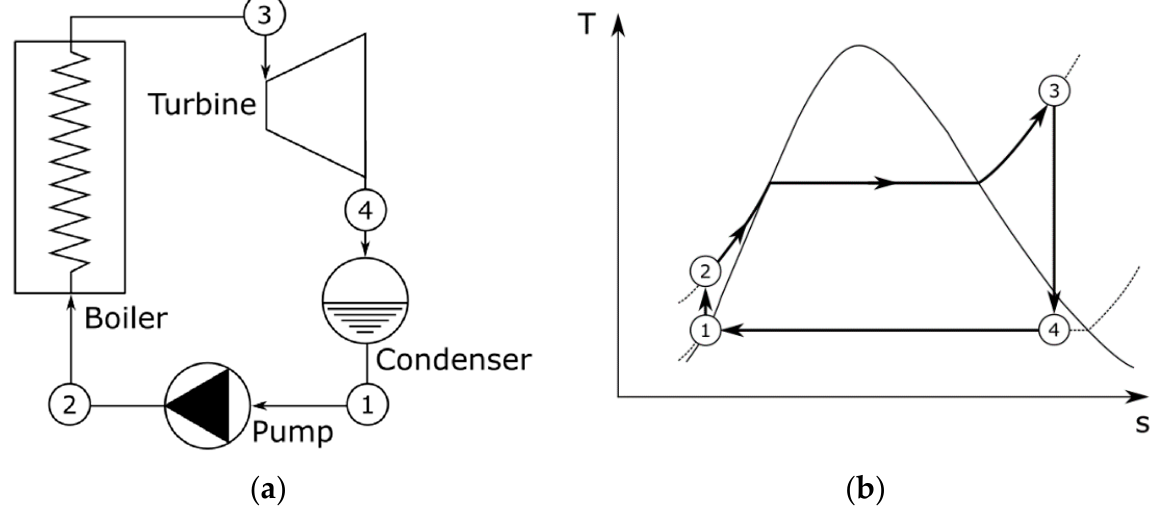
Figure 13. ( a ) Equipment and ( b ) T-s diagram of an ideal Rankine cycle.